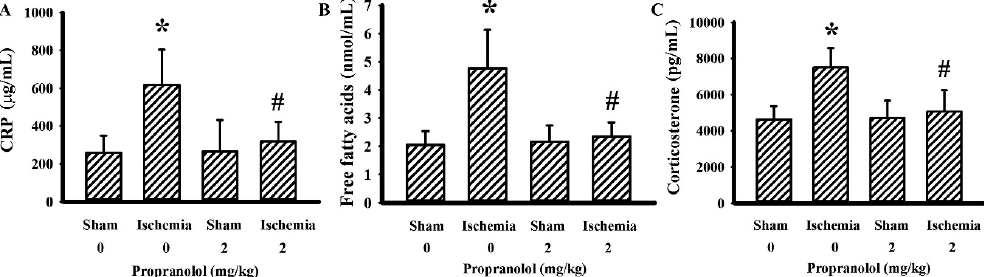
Figure 3. Propranolol alleviated postischemic changes in plasma biochemicals. Rats receiving a normal saline vehicle or a propranolol (2 mg/kg) intraperitoneal injection were subjected to sham or permanent cerebral ischemia for 24 h. The blood samples were collected and subjected to the measurement of C-reactive protein (CRP) ( A ), free fatty acids ( B ), and corticosterone ( C ). * p < 0.05 vs. sham/saline group and # p < 0.05 vs. ischemia/saline group, n = 6.